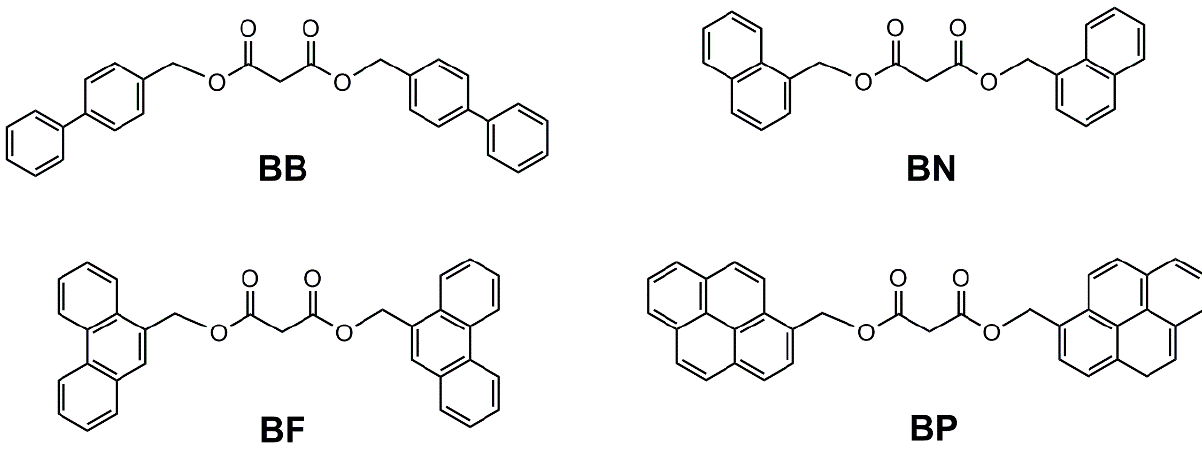
Figure 1. Structures of synthesized malonate derivatives. Bis([1,1 (cid:48) -biphenyl]-4-ylmethyl) malonate (BB